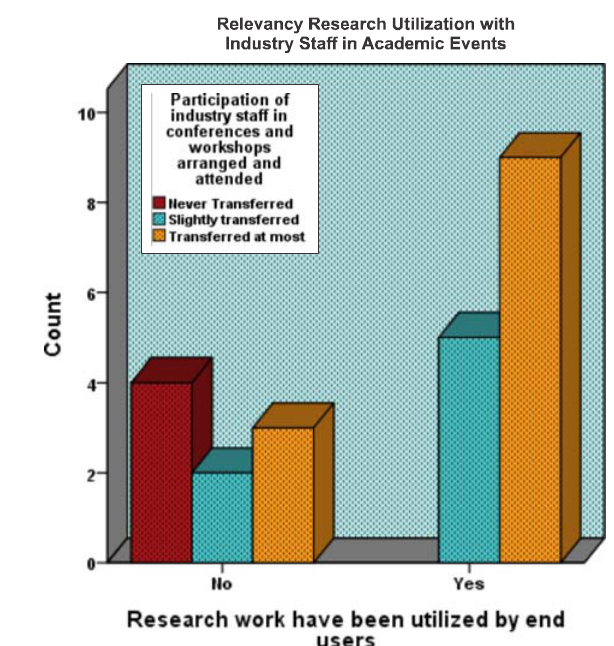
FIG. 3. ROLE OF PARTICIPATION OF INDUSTRY STAFF IN ACADEMIC ACTIVITIES TOWARDS UTILIZATION OF